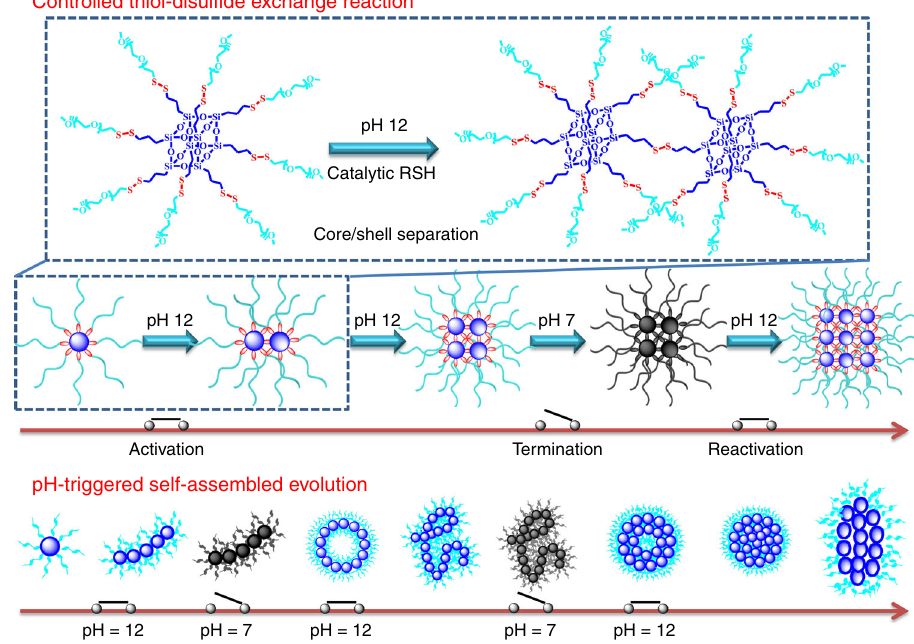
Fig. 1 Controllable strategy for morphology evolution with a pH-switched on/off function. Schematic representation of the living controlled thiol – disul fi de exchange reaction and the pH-triggered self-assembled evolution. When the thiol – disul fi de exchange reaction is activated in the presence of catalytic thiols in pH 12 solutions, the selective core/shell separation gradually leads to the continuous connections of POSS-embedded cores; in this case, the self- assembled evolution is performed from unimolecular micelles to the elliptic nanoparticles. Once neutralizing the system pH to 7 at any moment, the exchange reaction is deactivated, and thus no further morphology evolution is conducted any more. However, these stable inert sites can be reactivated by basi fi cation whenever needed, and the trapped morphology evolution can return back on the previous